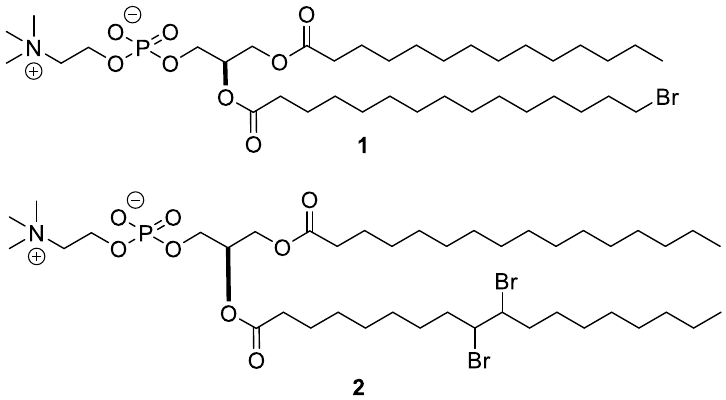
Figure 1. Structures of the bromo-phospholipids.